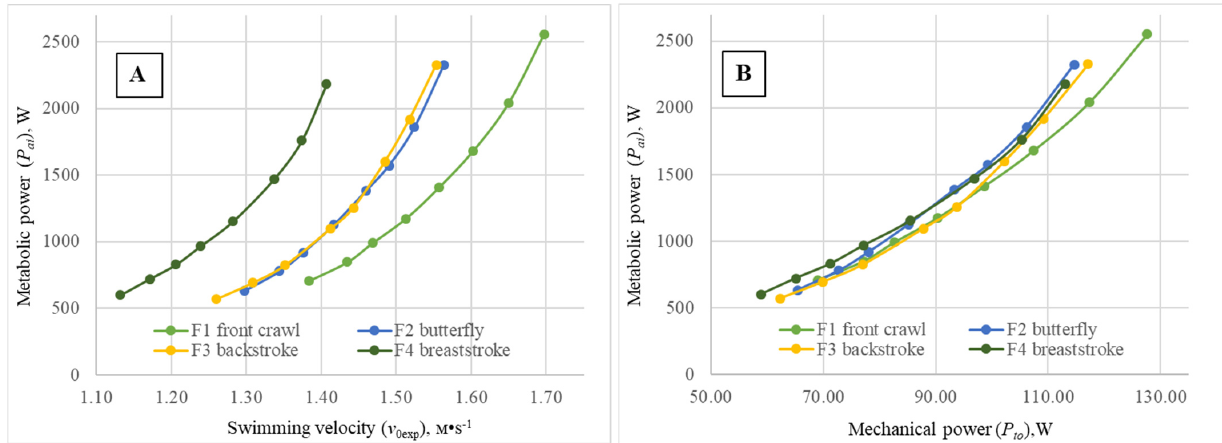
Figure 1. Functional relationships between v 0exp and P ai ( A ), and between P to and P ai ( B ) in the swimming pool 8 × 100 m